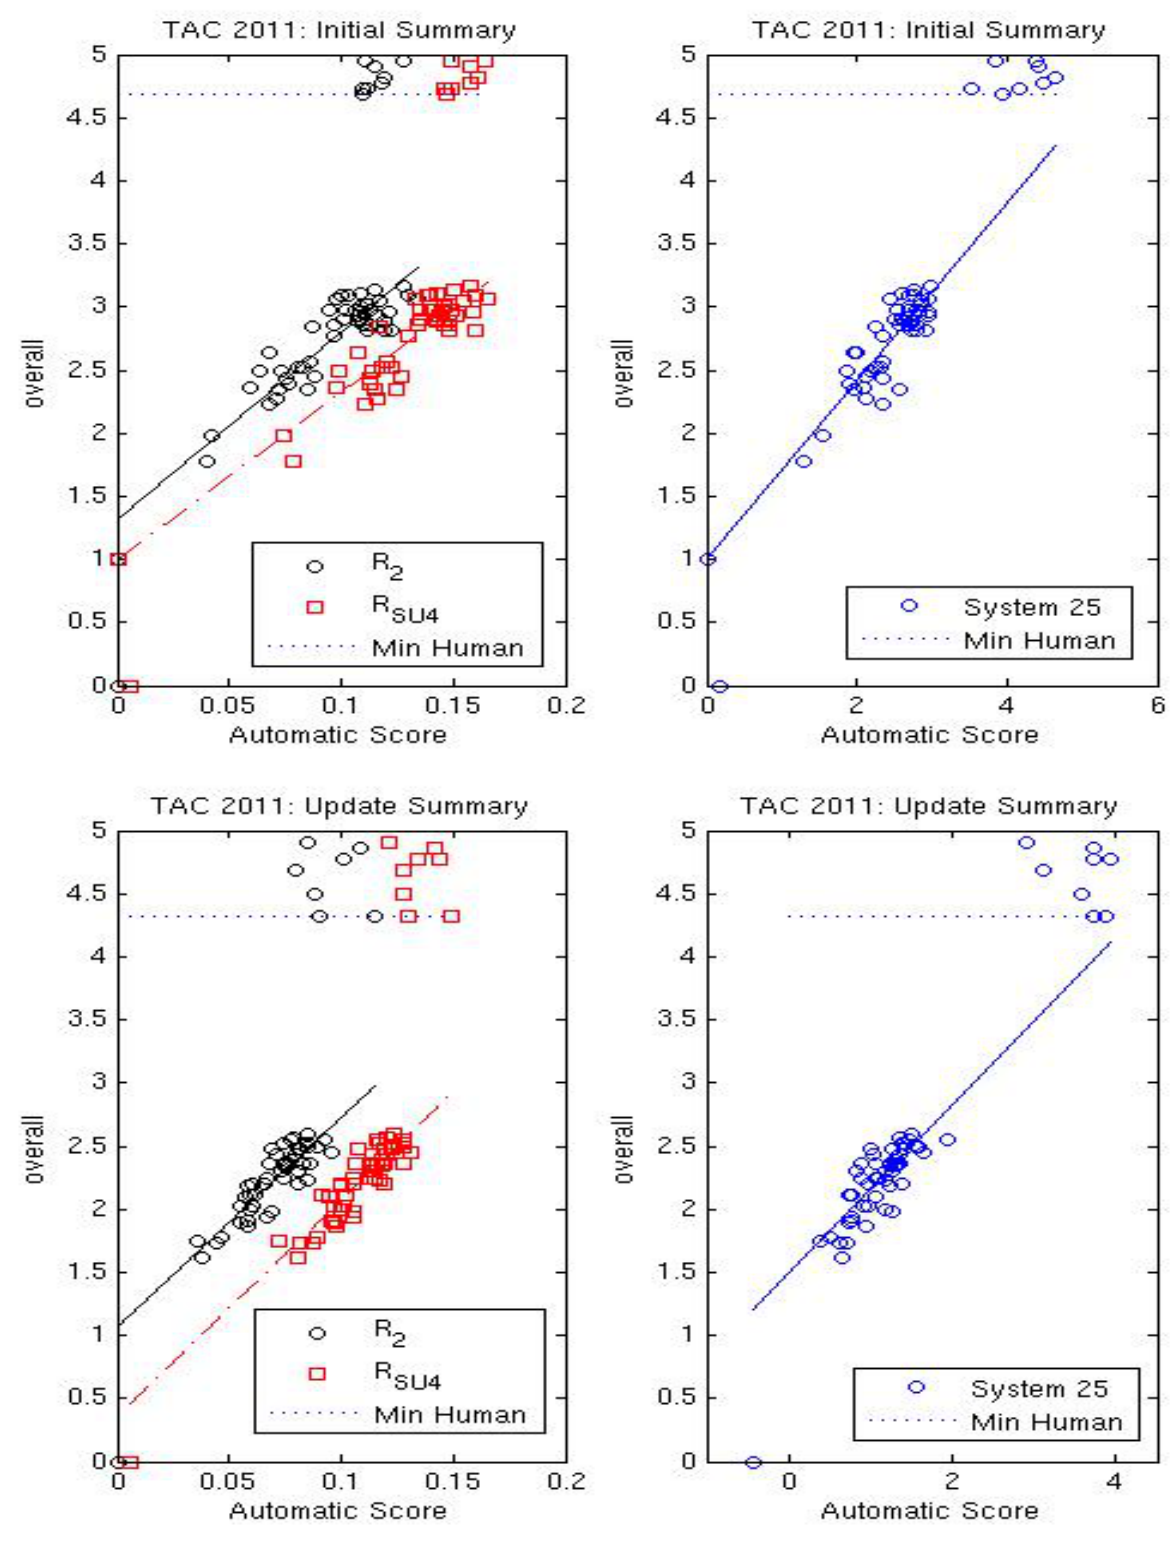
Figure 6. The performance of our System 25 at TAC